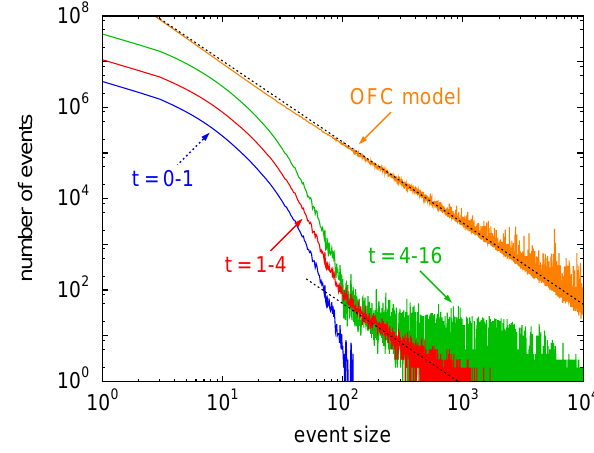
Fig. 1. Event-size statistics of the modified OFC model with- out supercritical forces measured over different time intervals on a 4096 × 4096 grid with α = 0 . 2 and random initial values. The orange line refers to 2 × 10 9 events in the quasi-steady state of the original OFC model. The dashed lines correspond to a power-law distribution with a scaling exponent τ = 1 . 775 that is discussed in Sect.